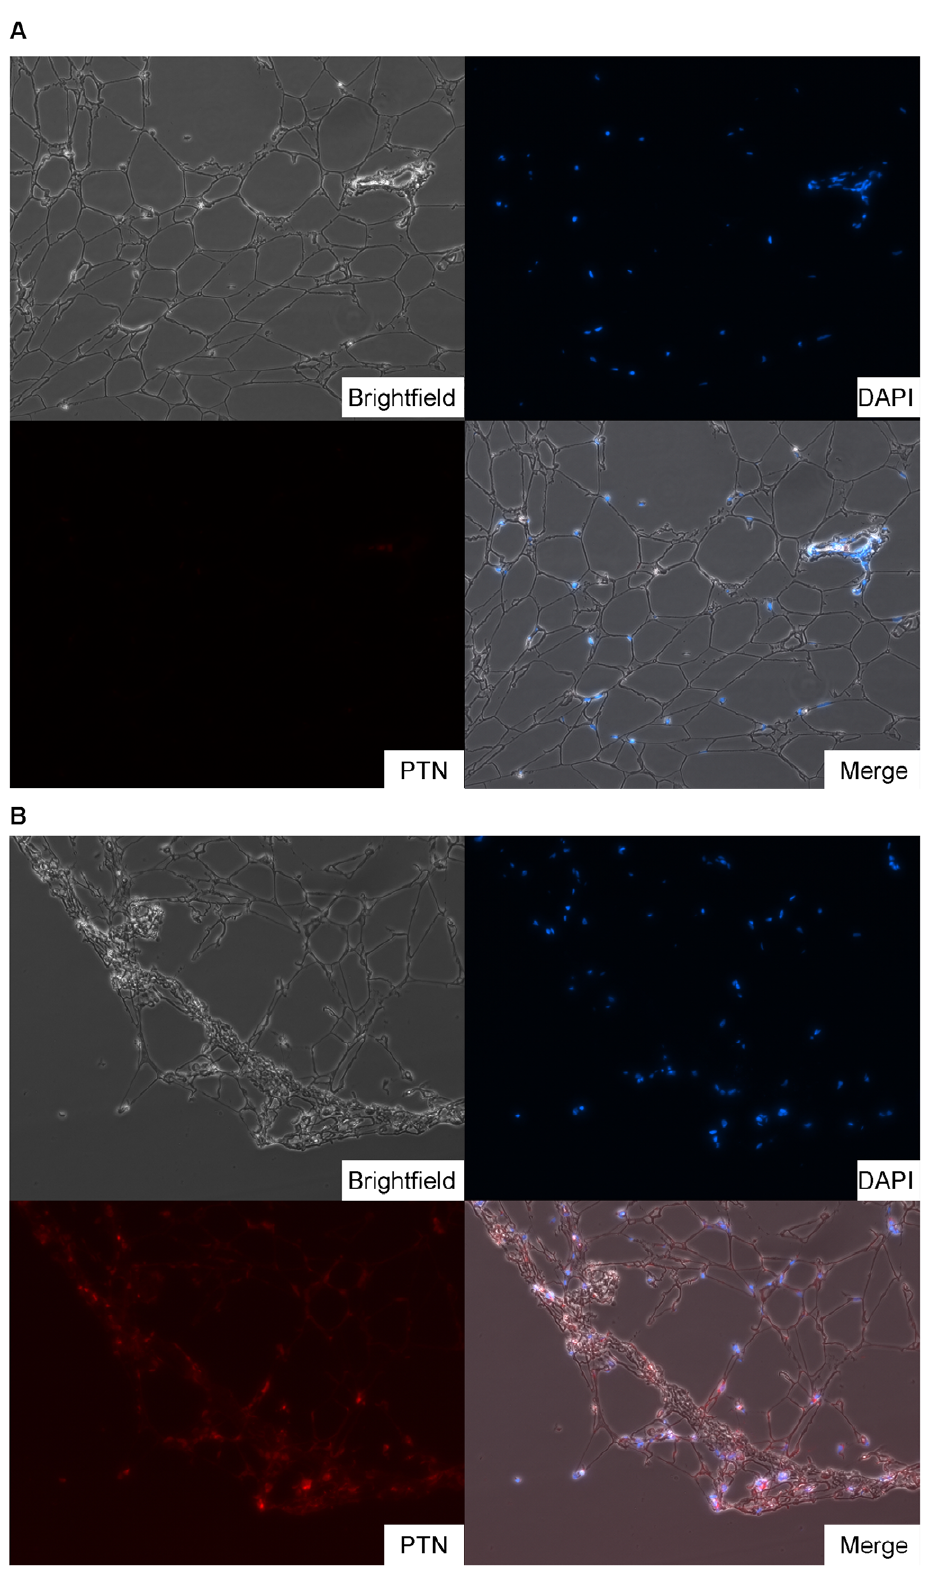
Figure 4. Pleiotrophin (PTN) immunostaining. DAPI = nuclear stain, PTN = antibody staining for pleiotrophin, Merge = composite image merging Brightfield, DAPI, and PTN channels. A) No PTN is seen in pediatric subcutaneous adipose tissue from Patient 7. B) Large PTN aggregates are seen in macrodactyly patient 4.